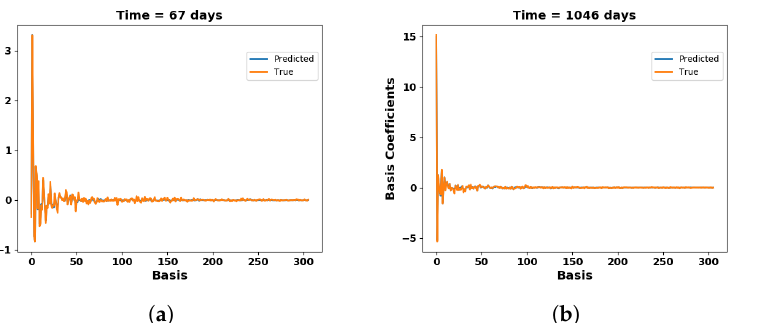
Figure 38. True and ML predicted pressure basis coefficient comparison at time = ( a ) 506 days and